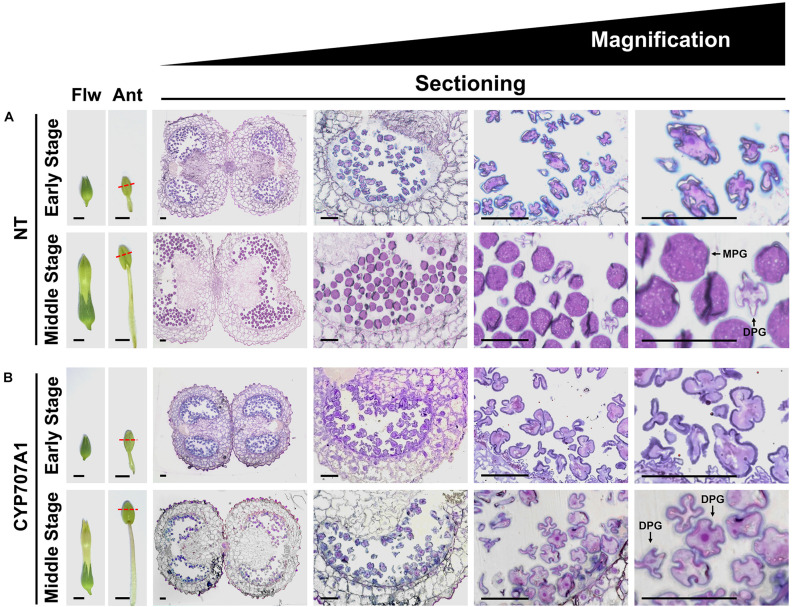
Overexpression of CaCYP707A1 affects pollen maturation. (Left) Images of flowers (Flw) and anthers (Ant), and (right) semi-thin section images showing pollen development in early stage and middle-stage flowers of NT (A) and 35S:CaCYP707A1 #1 (CYP707A1) plants (B) grown in the same conditions. The slices were stained with toluidine blue O, and the images were captured by light microscope. Red dashed lines marked the longitudinal positions from which the slices were obtained. Ant, anther; DPG, degenerated pollen grain; Flw, flower; MPG, mature pollen grain. Scale bars = 0.5 cm in flowers, 0.2 cm in anthers, and 50 μm in sectioning images. More than three individuals of the indicated plants were analyzed, and the experiments were performed two times with similar results.